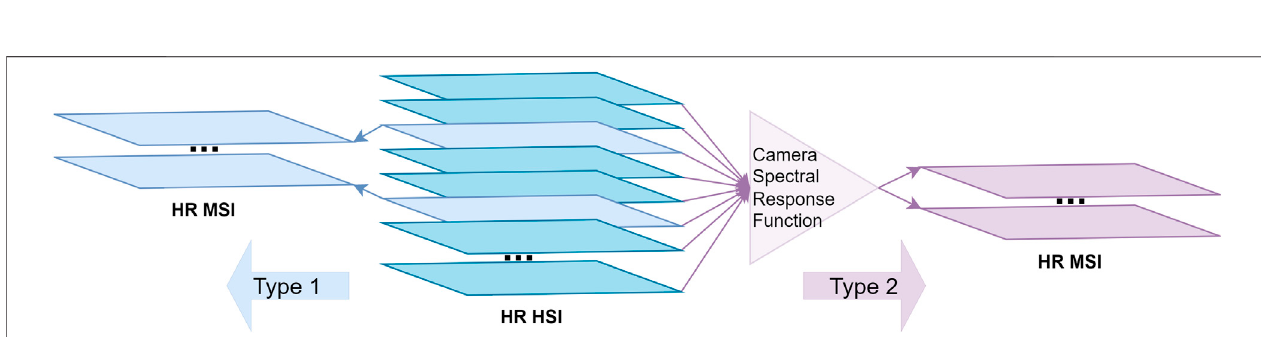
FIGURE 2 | Two different data formation strategies for HR MSI generation.